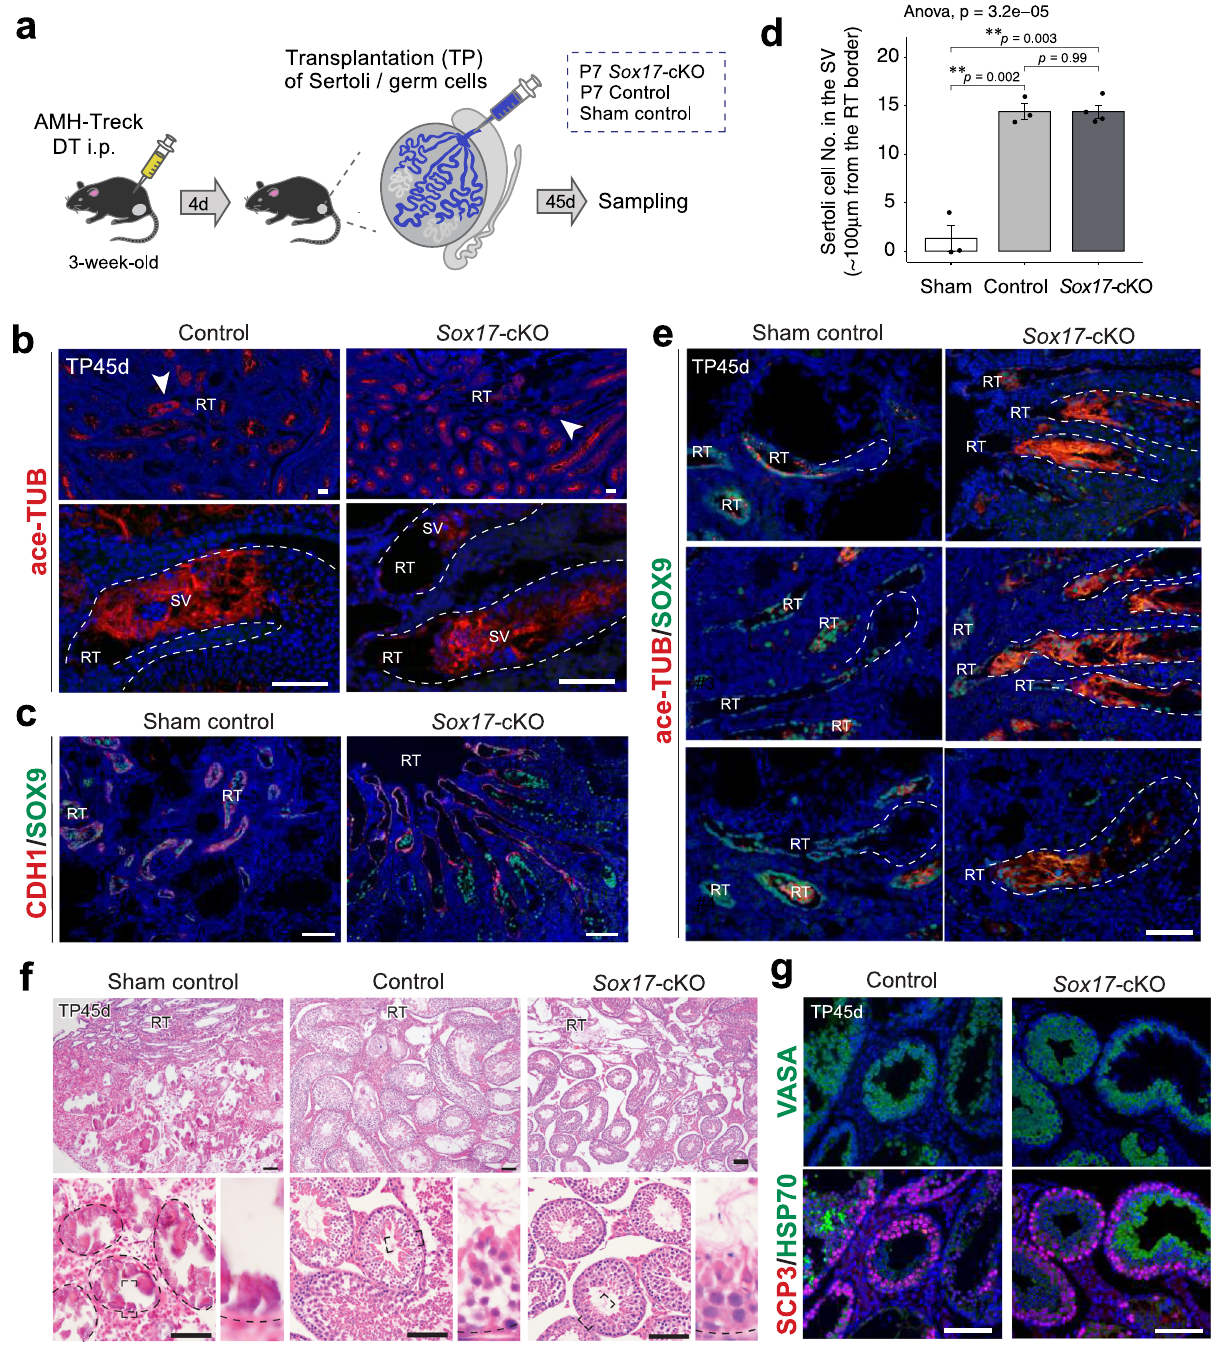
Fig. 7 | Reconstruction of the SV and spermatogenesis by the Sertoli cells of Sox17- cKOmice.a AschematicofSertolicellablation/transplantationexperiment. Sertoli and germ cells of Sox17- cKO mice, their littermate wild-type control (con- trol),ortrypanblue(shamcontrol)wereinjectedintothetestisof AMH-Treck mice, respectively. In thisexperiment, AMH-Treck males were pretreated with diphtheria toxin (DT) to ablate the endogenous Sertoli cells on 4 days prior to the trans- plantation. b – e Sertoli cells of Sox17 -cKO mice reconstituted ace-TUB + valve-like structure at the presumptive SV region adjacent to the host RT (SOX9 + /CDH1 + ). Sertoli cells of control mice also constructed the SV (b), while sham control testis did not show any valve-likestructure at the SV( c , e ).The number of Sertolicells in the putative SV region was similar between the Sox17- cKO group and the control group( d ).Shamcontrol n =3.Control n =3. Sox17- cKO n =4.In( b ),( c ),and( e ),the testes shown in the left panel and the right panel are contralateral testis from the same animal. In e, the top, middle, and bottom panels show data obtained from